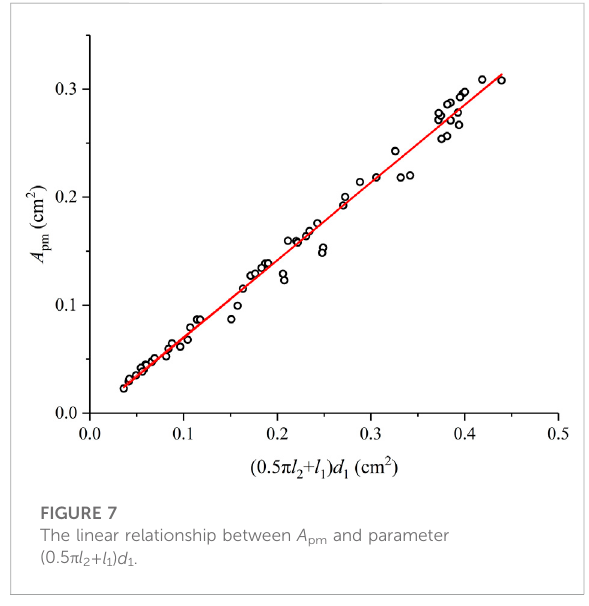
FIGURE 6 Main shape parameters of the Oncomelania with the original and processed images.